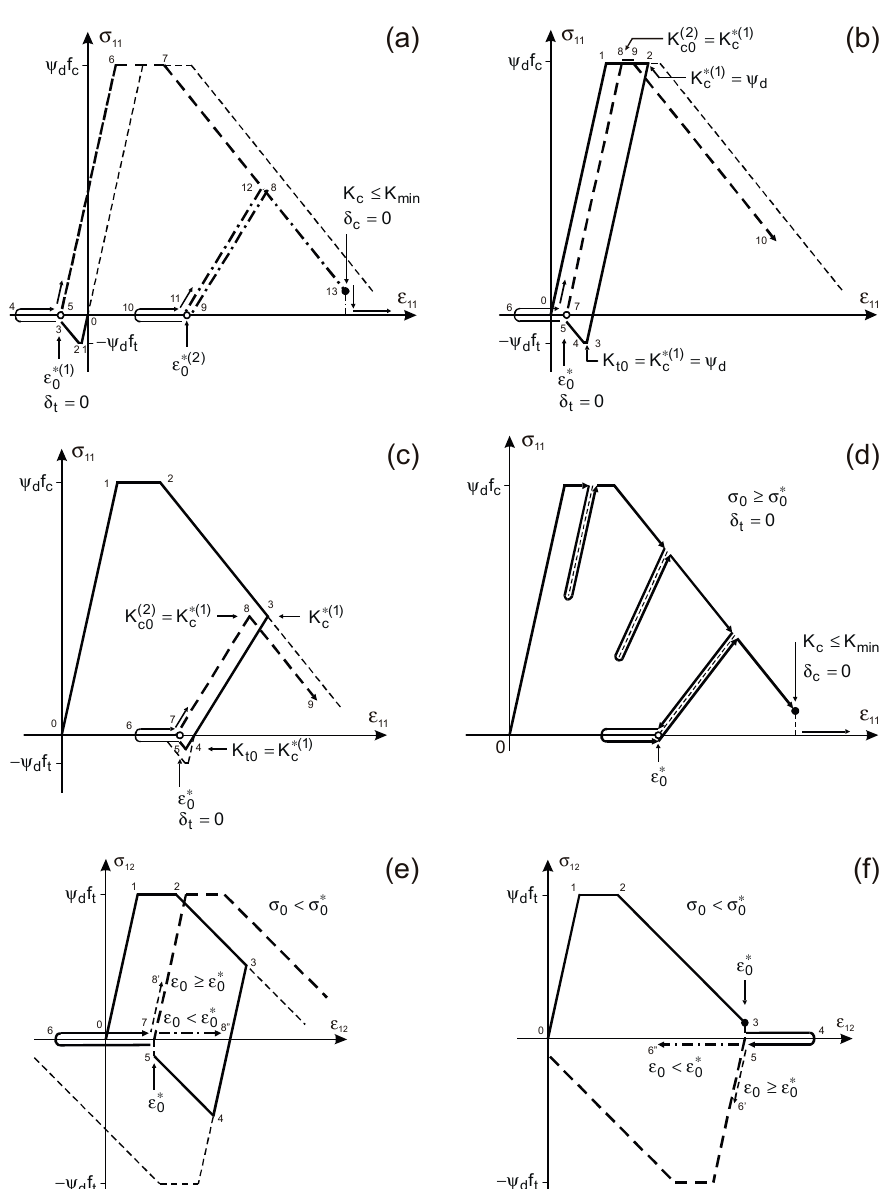
Figure 4. Schemes of approximate modeling of cracking and crushing for concrete (description in text): ( a ) crack opening in tension path 0-1-2-3-4 / re-compression after crack closing path 5-6-7-8 / unloading path 8-9 / secondary crack opening path 9-10 / secondary crack closing and re-compression path 11-12-13; ( b ) compression path 0-1-2 / unloading and tension path 2-3-4-5 / crack opening path 5-6 / secondary loading and crack closing path 6-7 / re-compression path 7-8-9-10; ( c ) advanced compression to material softening range path 0-1-2-3 / unloading with current deformation modulus and tension path 3-4-5 / crack opening path 5-6 / secondary loading and crack closing path 6-7 / re-compression path 7-8-9; ( d ) attaining of the crushing state in the material softening process with local unloading and re-loading paths; ( e ) advanced shear stress state: loading path 0-1-2-3 / unloading path 3-4-5 / loss of load capacity with associated tension path 5-6 / re-loading path 6-7 with associated compression or tension; ( f ) attaining of the semi-failure state in the shear stress state path 0-1-2-3 / loss of load capacity 3-4 / re-loading path 4-5 with associated compression or tension.